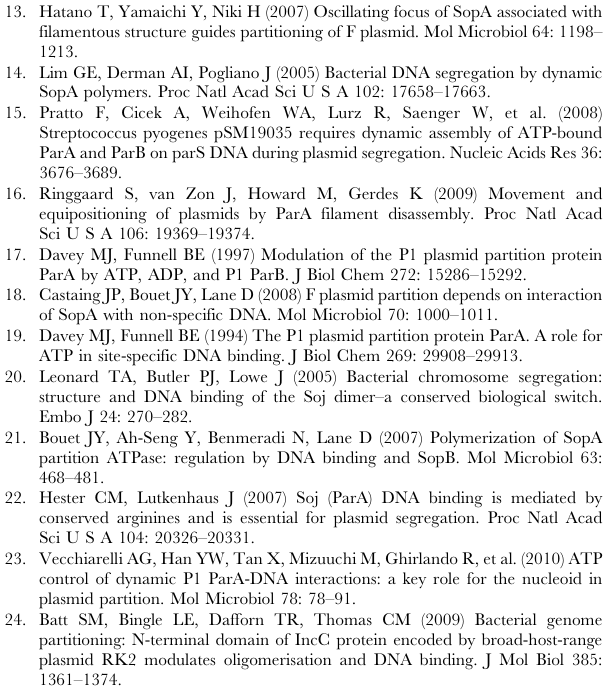
Table S1 Effect of the sopB-R36A mutation in trans on mini-F ( D ( sopAB ), sopC + ) stability. LR - % mini-F lost per generation, average of two or three determinations; SF - stabilization factor (LR D sopB /LR sopB + /R36A ); DsF - destabilization factor (LR sopB R36A / LR sopB + ); U-mF – concentration of SopA relative to that in cells carrying wt mini-F (pDAG114), determined independently for each of the strain-growth medium combinations. Corresponding SopA concentrations are shown, as the average values obtained for